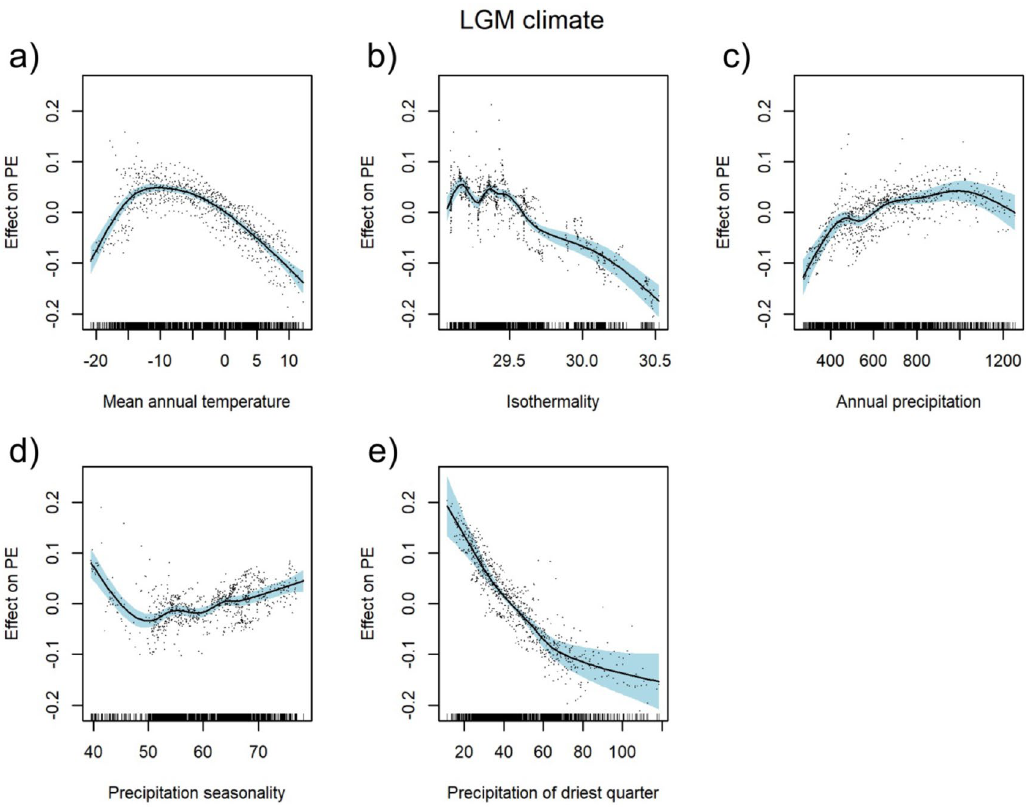
Figure 3. Partial response curves of Last Glaciation Maximum (LGM) climate predictors with smooth effects in the generalised additive model (GAM). Effect of annual mean temperature [°C] ( a ), isothermality [%] ( b ), sum of annual precipitation [mm] ( c ), precipitation seasonality [%] ( d ), and precipitation of the driest quarter [mm] ( e ); PE proportion of endemic plant species to overall plant species richness as target variable. For model summary of the GAM see Table